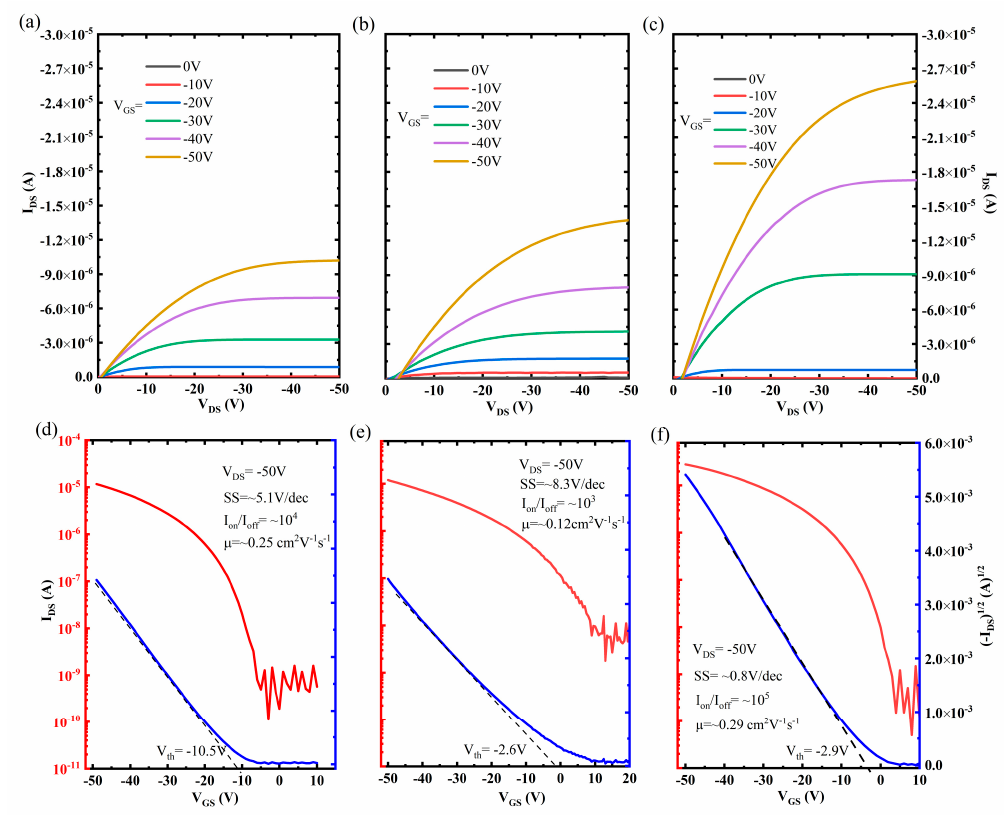
Figure 3. The output and transfer curves of the OFETs with (a)(d) poly (4-vinyl phenol) (PVP), (b)(e) PVP:CaTiO 3 NPs, (c)(f) PVP:CaTiO 3 NPs (3 wt%)/PVP dielectric, respectively. (a), (b), (c) and (d), (e), (f) are in the same scale, respectively. Table 1. Performance criteria of organic field-effect transistors (OFETs) with different dielectrics. Dielectric